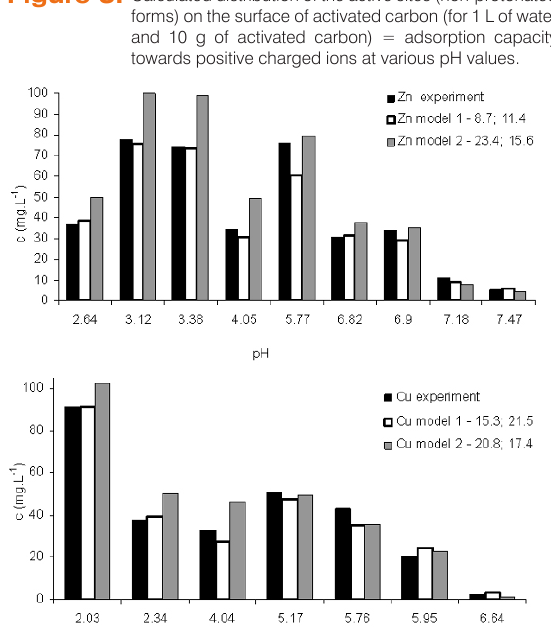
Figure 4. Concentrations of both metals in the solution after adsorption for various values of pH: experimental data in comparison with models results after calibration by finding of suitable combinations of the sorption equilibrium constants. There are average deviations (%) between experiment and model for all data (first value) and for data with pH > 5.77 (Zn) and pH > 5.17 (Cu) marked in the legend (single metal